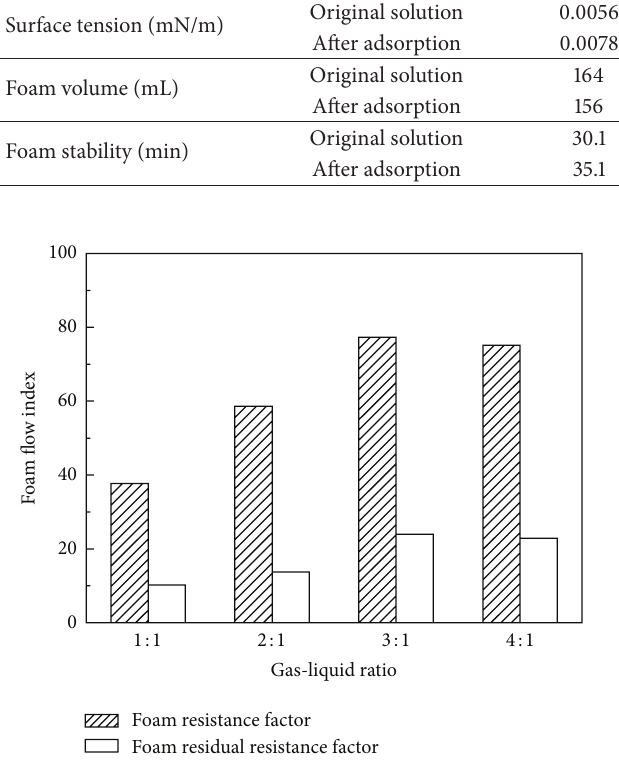
Figure 6: Effect of gas-liquid ratio on foam flow resistance. Figure 7: Effects of the gas-liquid alternate period on foam flow